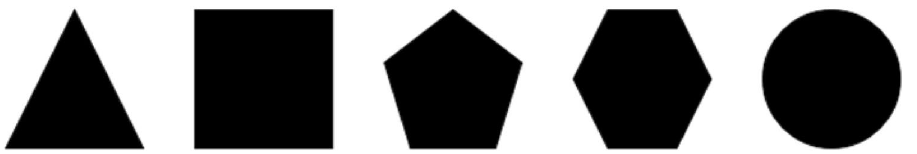
Figure 4. Reference geometric shapes used in this